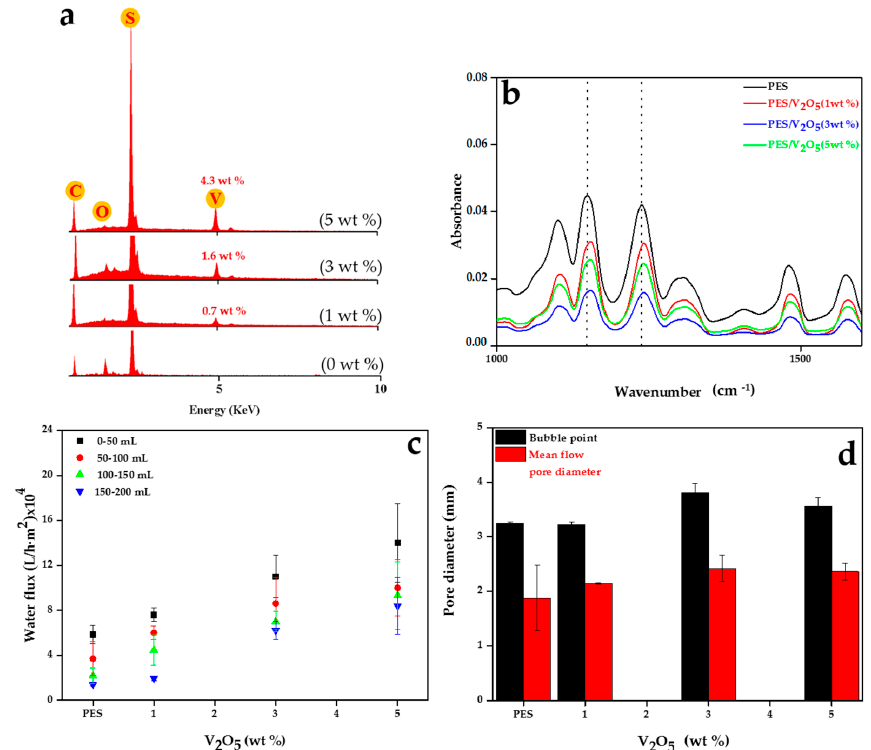
Figure 2. Chemical surface analysis of the PES electrospun nanofibrous adsorbents (ENAs) containing 0–5 wt % V 2 O 5 nanoparticles through ( a ) energy dispersive X-ray spectroscopy (EDX) analysis and ( b ) attenuated total reflection Fourier transform infrared (ATR-FTIR); and different membrane characteristics of the PES ENAs including ( c ) water flux and ( d ) pore size.